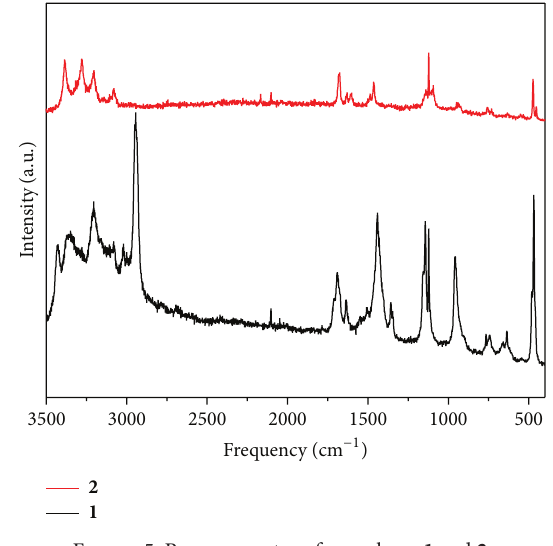
Figure 5: Raman spectra of complexes 1 and 2 .